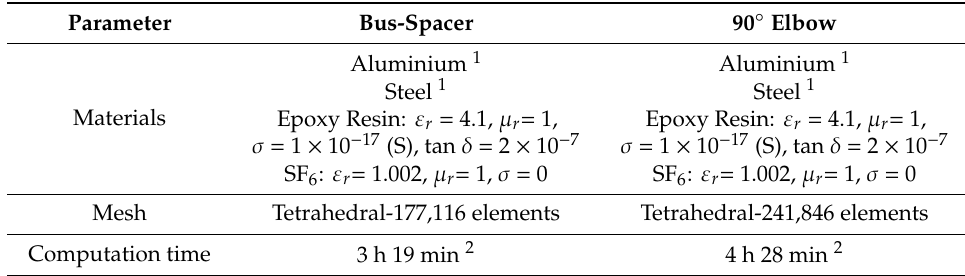
Table 1. Summary of finite element method (FEM) simulation parameters.